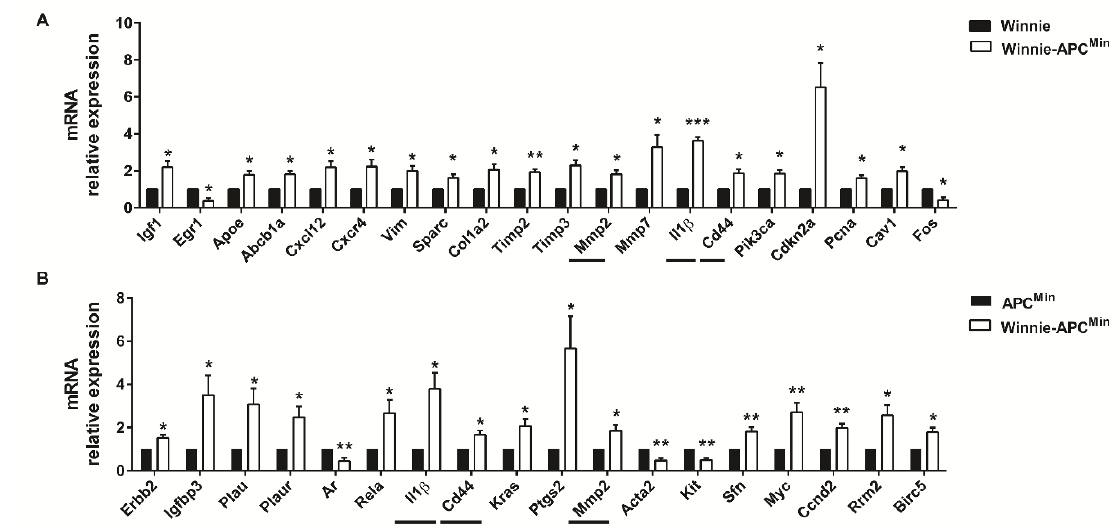
Figure 4. Molecular pathways activated in 5-week-old Winnie- APC Min /+ mice. The distal colon of Winnie- APC Min /+ mice (white bars) was analyzed by qPCR relative to Winnie ( A ) and APC Min /+ ( B ) mice (black bars) ( n = 3–4 animals / group). Horizontal lines indicate common genes between the two comparisons. Histograms represent the mean ± SEM. * p < 0.05, ** p < 0.01, *** p < 0.001.